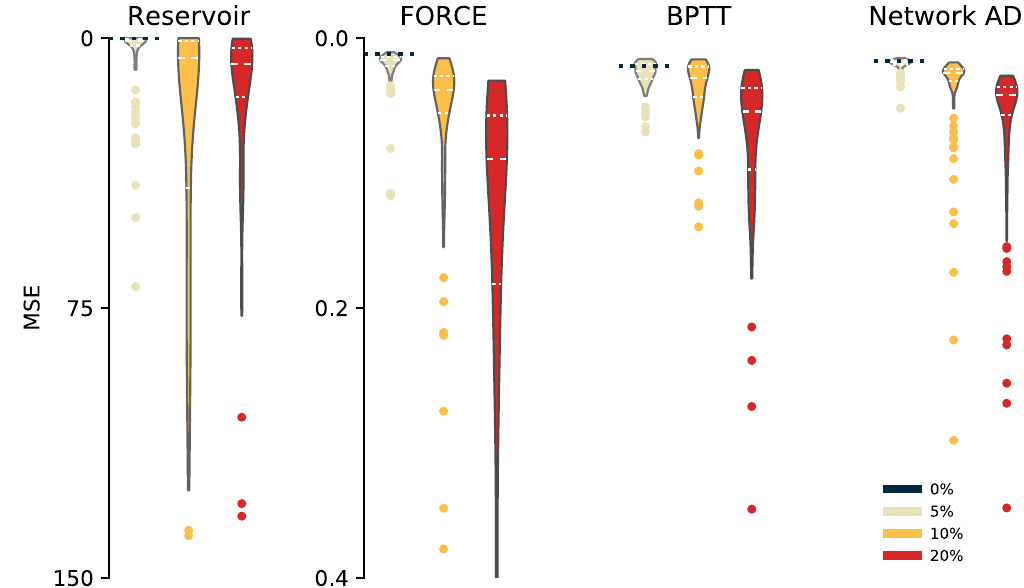
Figure 5. Under simulated deployment, our method is more robust to mismatch than standard training approaches. Shown are the distributions of errors (MSE) between the non-spiking teacher RNN and final trained SNN response for 10 random initialisations of training for each architecture and 10 random instantiations for each level of mismatch. Dashed black line: baseline network with no mismatch ( δ = 0% ) for each architecture. See text for statistical